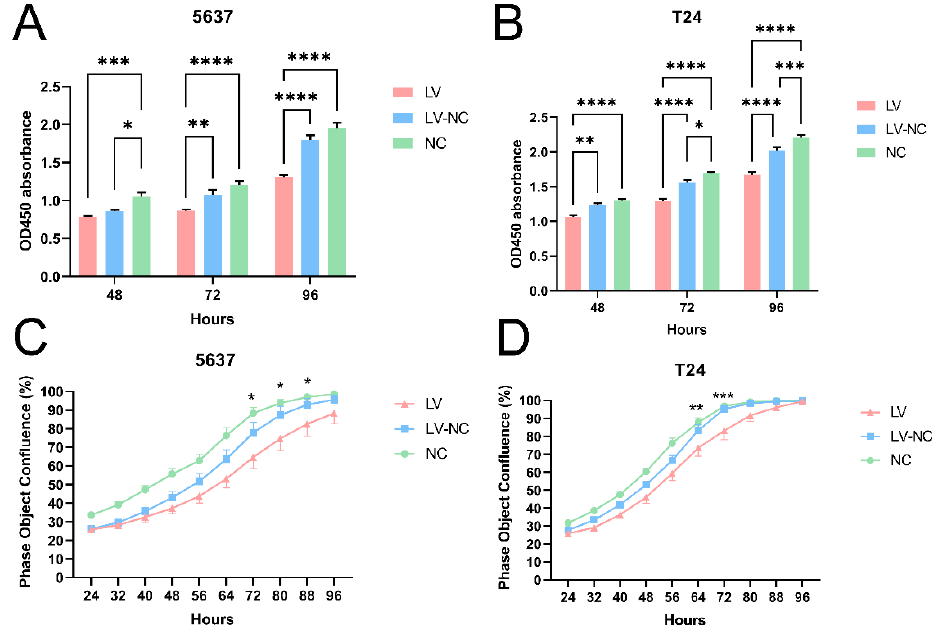
Figure 2. TiRNA-Gly-GCC-1 could promote cell proliferation and confluence (transfection group, LV; negative control group, LV-NC; blank group, NC). ( A ) CCK-8 assay: OD450 absorbance in 5637 cells. ( B ) CCK-8 assay: OD450 absorbance in T24 cells. ( C ) Cell confluence in 5637 cells. ( D ) Cell confluence in T24 cells. * indicates p -value < 0.05. ** indicates p -value < 0.01. *** indicates p -value < 0.001. **** indicates p -value < 0.0001.